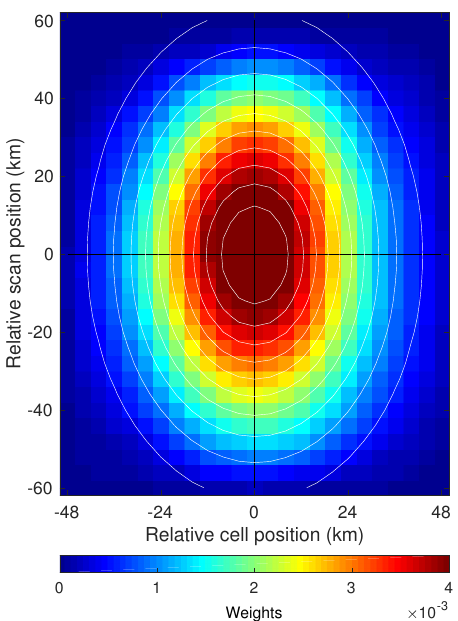
Figure 10. AMSR-E footprint obtained by averaging the across-track footprints shown in Figure 9. Contour-lines of the fitted analytic model (Equation (9)) are superimposed and plotted in white color. The standard error of the mean of the weights does not exceed 9 × 10 − 5 .